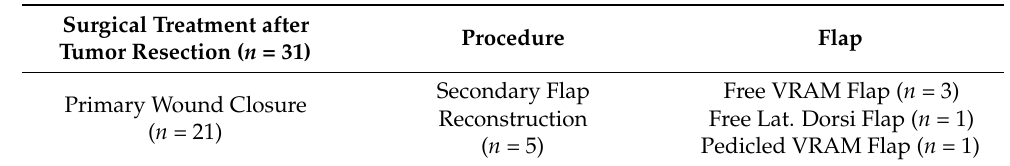
Table 2. Surgical Treatment after Extremity Soft-tissue Sarcoma Resection in 2021 (Sarcoma Center, University Hospital